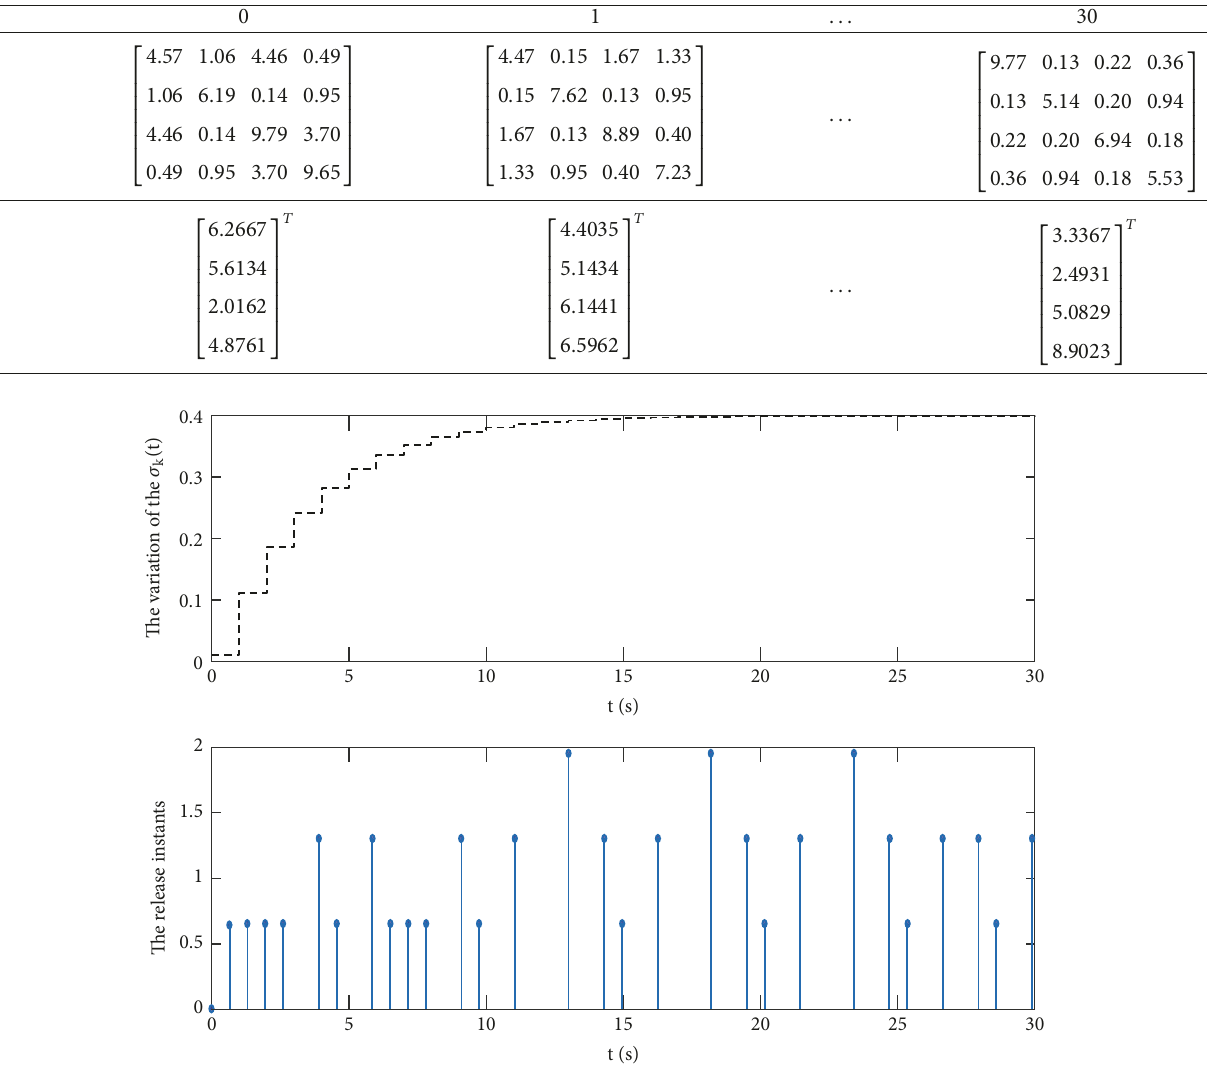
Figure 2: The variation of 𝜎 𝑘 (𝑡) and release instants, h=0.22.